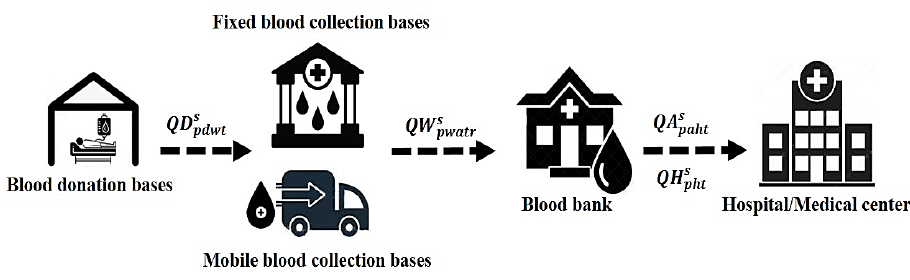
Fig. 1. Graphical representation of proposed reliable blood supply chain